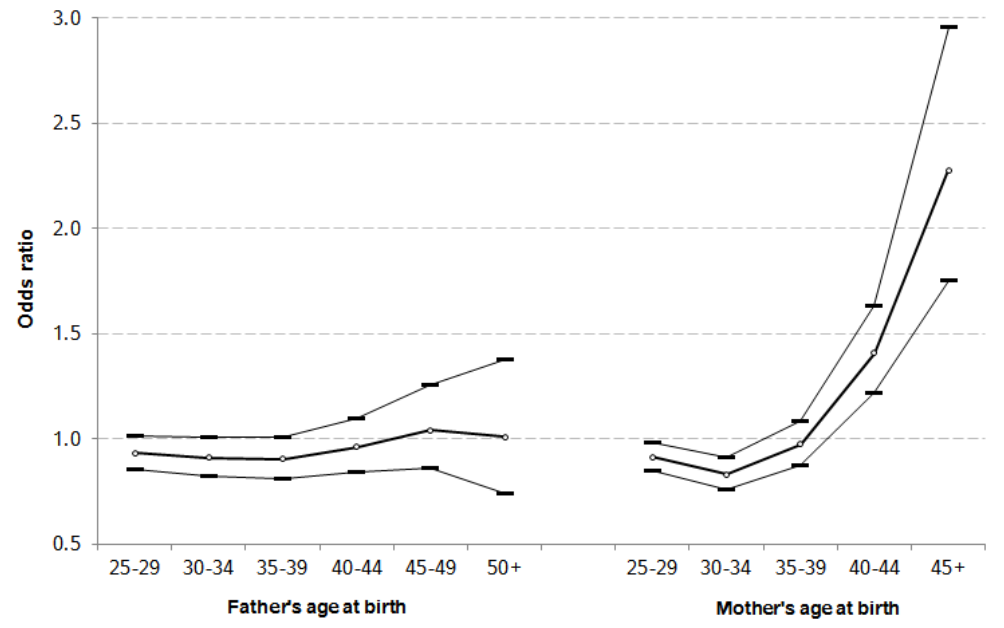
Figure 2: Relative odds of cognitive disability, by mother’s and father’s age at birth, with age <25 as the reference category for each (from Model 3 in Table 2, showing 95% confidence